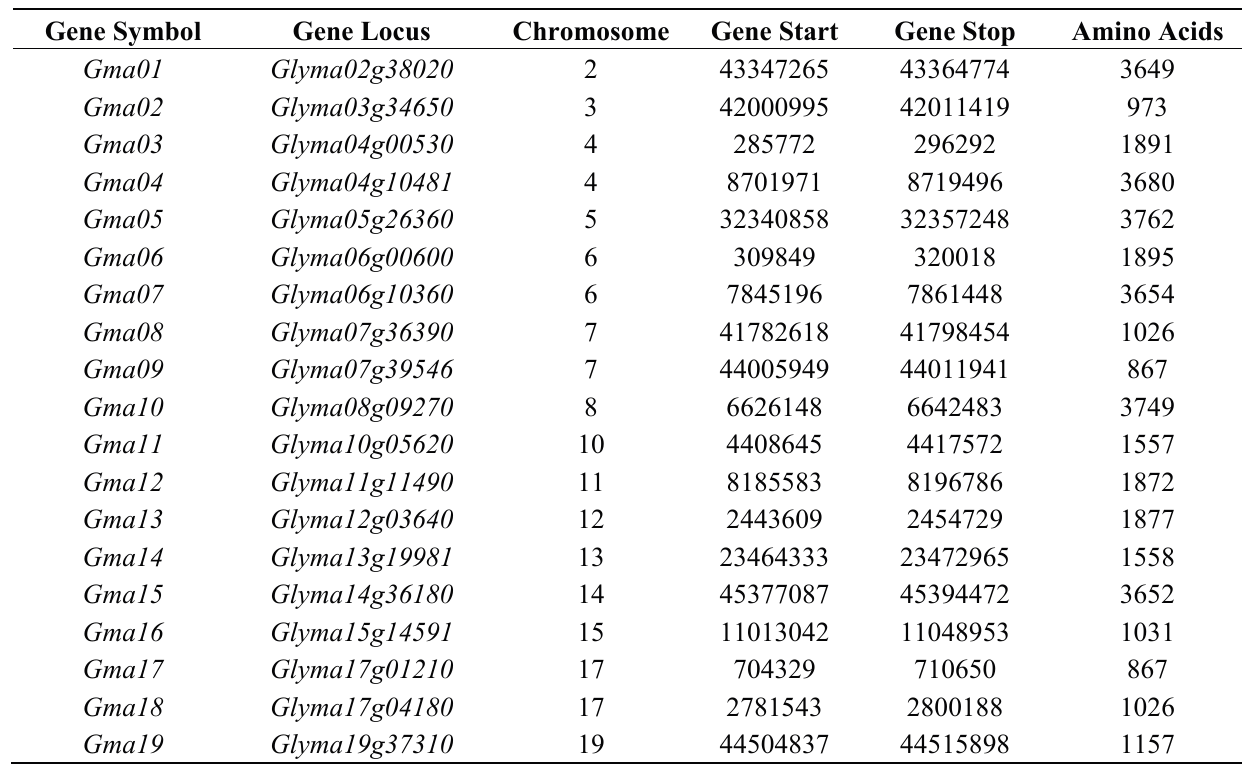
Table 1. The information relating to 19 homologous to the E6-associated protein (E6-AP) carboxyl terminus (HECT) genes in the soybean genome. Gene Symbol Gene